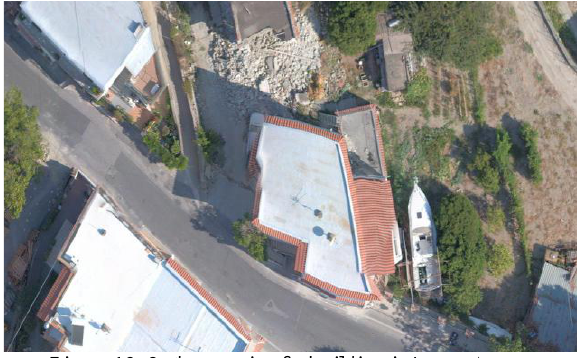
Figure 13. Orthomosaic of a building in Lacco Ameno